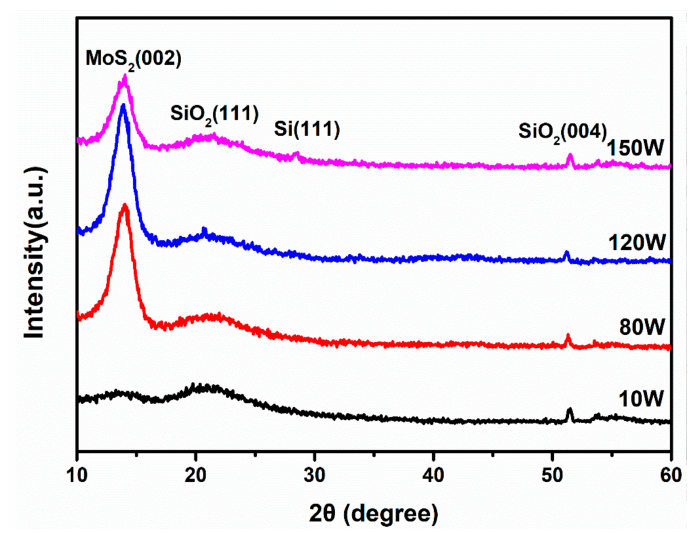
Figure 4. X-ray diffraction patterns of the MoS 2 thin films on SiO 2 /Si substrates under different RF sputtering